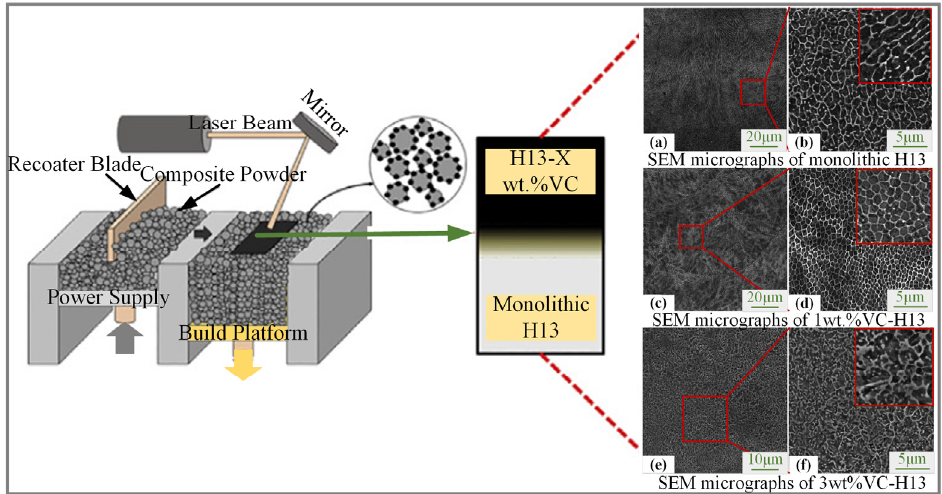
Figure 7. Schematic of LPBF [55]. ( a ) Overview of SEM micrograph for monolithic H13 ( b ) high- magnification image of the dashed square shown in ( a ), ( c ) Overview of SEM micrograph for 1wt.%VC-H13, ( d ) high-magnification image of the dashed square shown in ( c ), ( e ) Overview of SEM micrograph for 3wt.%VC-H13, ( f ) high-magnification image of the dashed square shown in ( e ) [55].